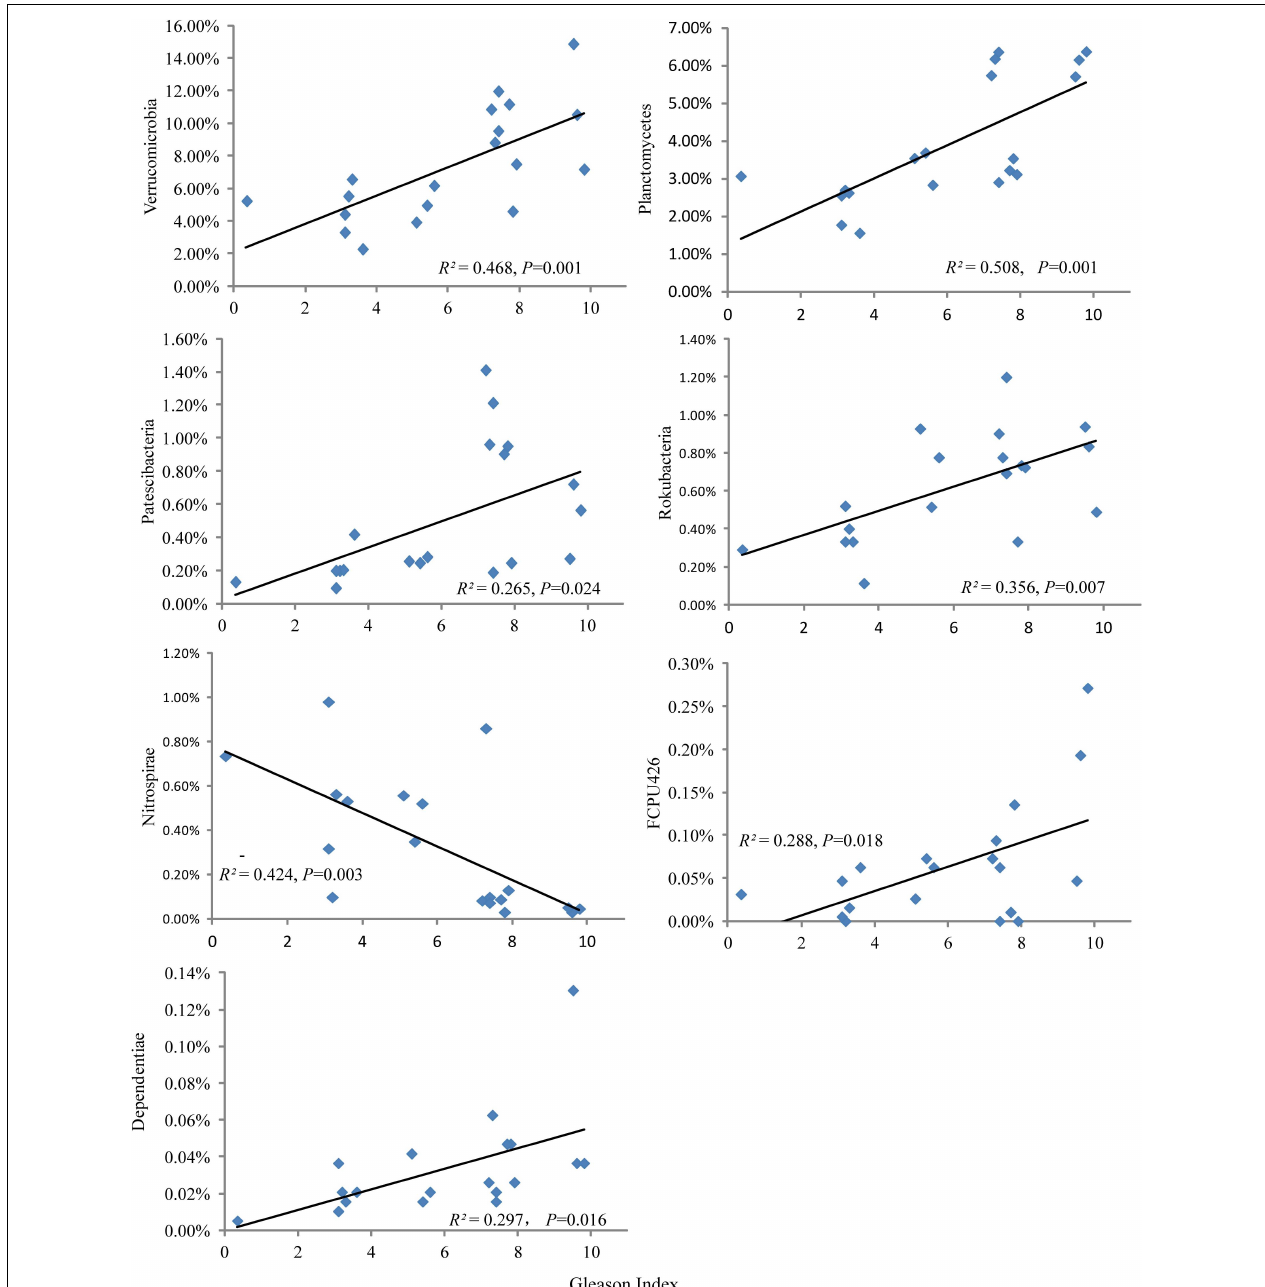
FIGURE 4 | Changes in the relative abundances of soil bacterial phyla with plant Gleason index.